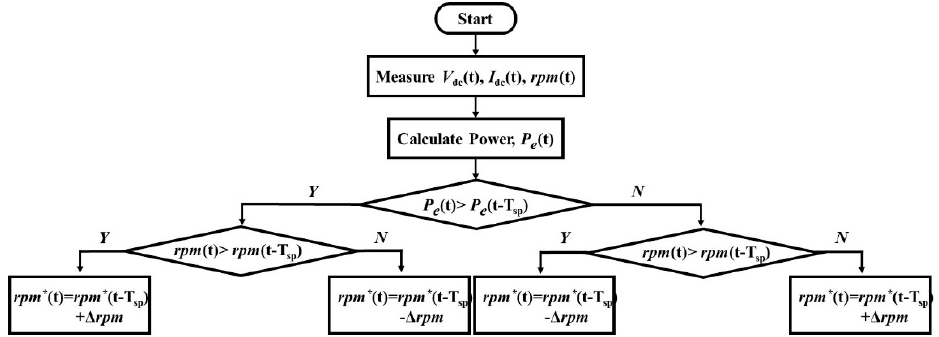
Figure 6. Flow chart of speed control algorithm based on the P&O algorithm for FWEC.